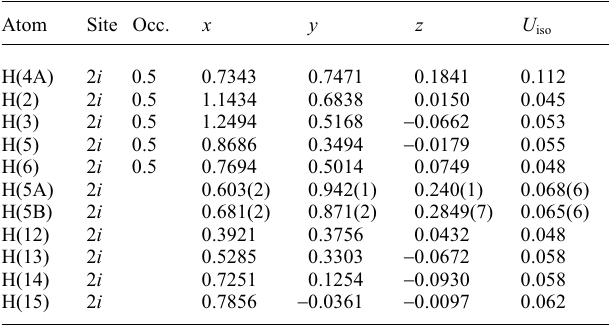
Table 2. Atomic coordinates and displacement parameters (in Å 2 ) .